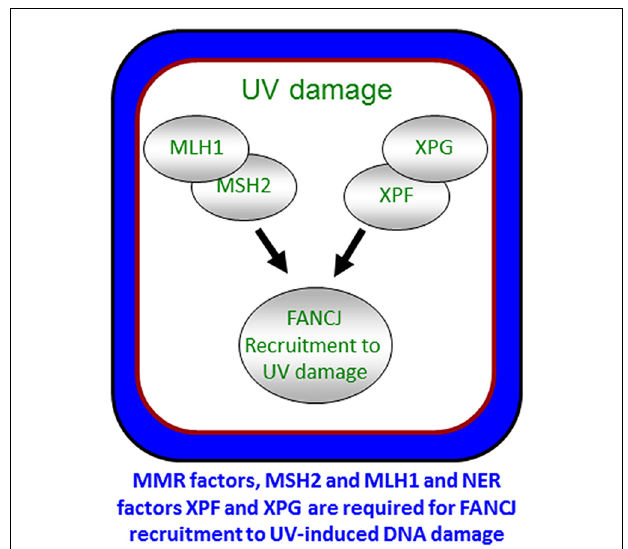
FIGURE 6 | Localization of FANCJ to UV-induced DNA damage. FANCJ recruitment to UV-induced DNA damage is dependent on the mismatch repair factors MLH1 and MSH2, and NER factors XPF and XPG. See reference Guillemette etal. (2014) and text for details.